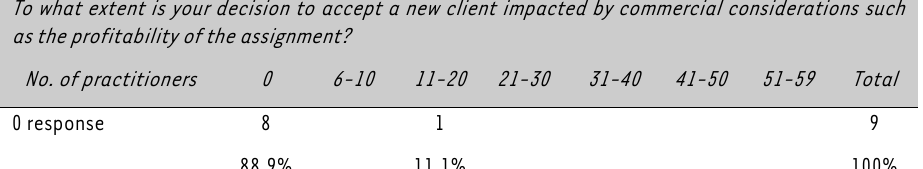
TABLE 3: Research results for question 1 Question